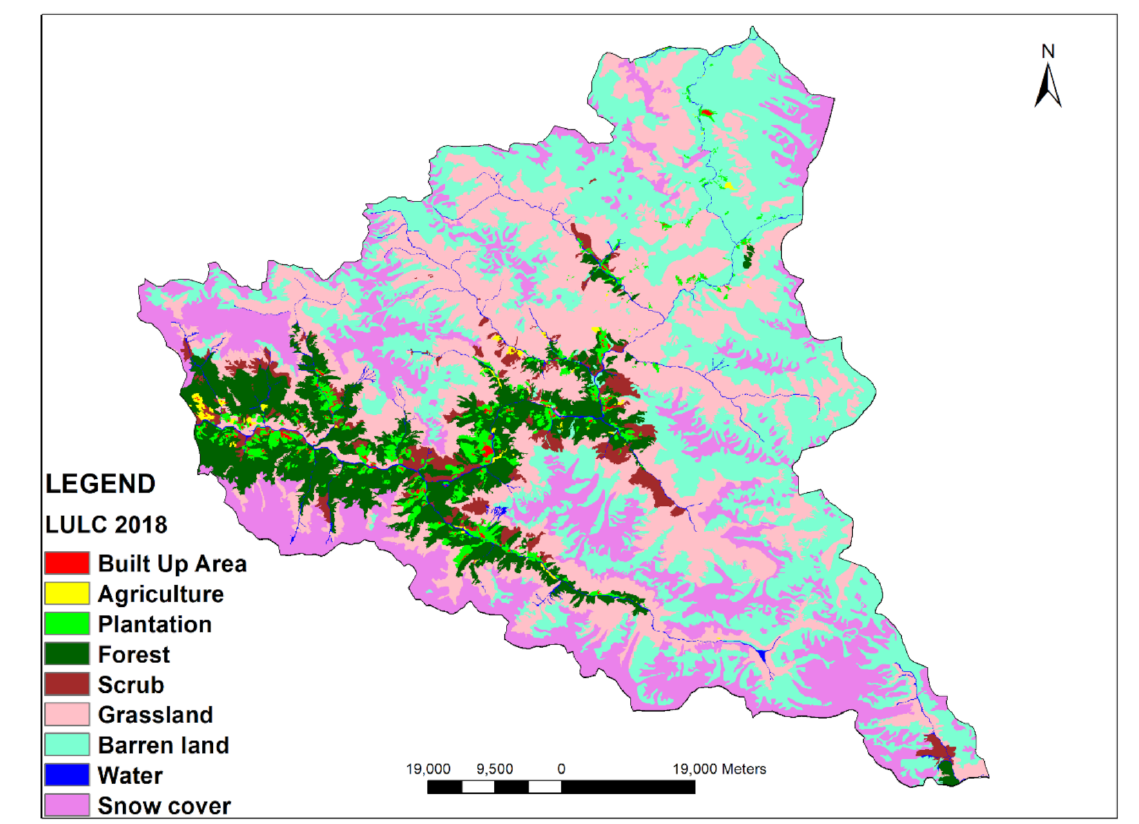
Figure 3. LULC for